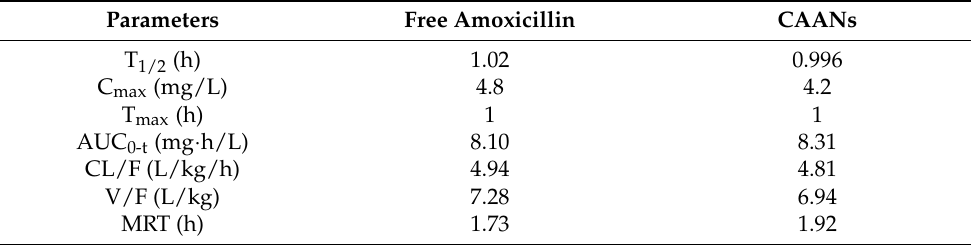
C max = maximum plasma concentration, T 1/2 = half-life, AUC 0-t = area under the curve, MRT = mean residence time, CL = clearance, V = volume of distribution, and F = bioavailability.